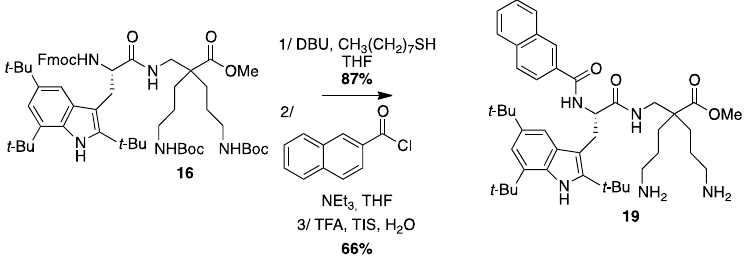
Figure 20 . HPLC profile of Fluo-Tbt-β 2,2 h bis-Orn-OMe 18